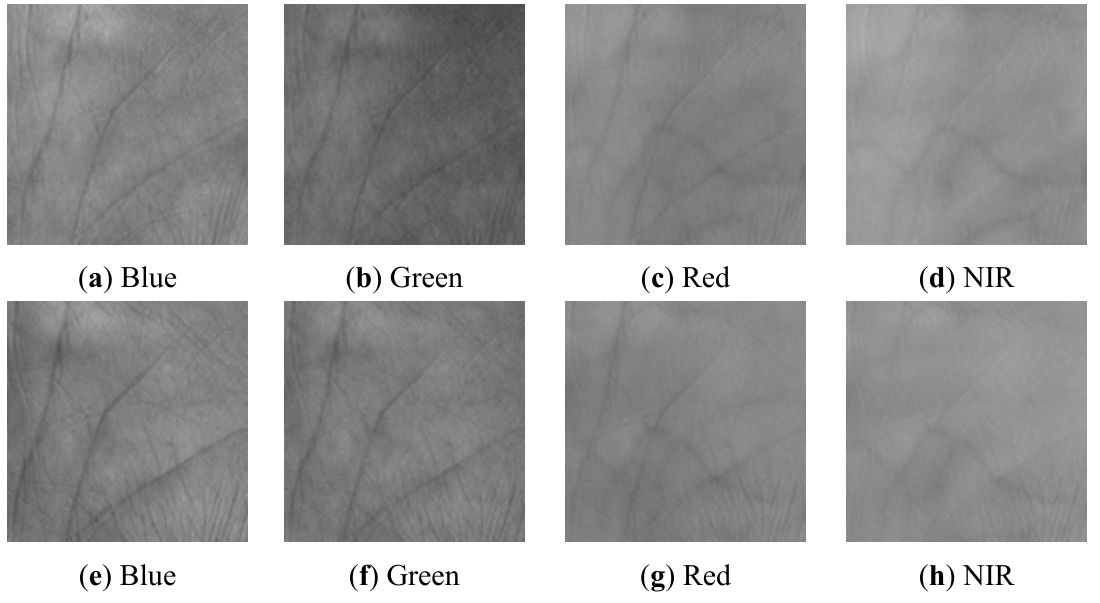
Figure 7. A pair of multispectral palmprint images from the same palm but falsely recognized. ( a-d ) are four images of one instance, and ( e-h ) are four images of another instance of different